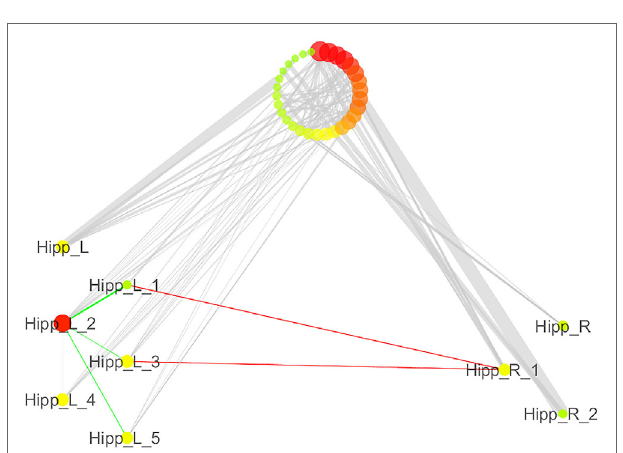
FigUre 7 | Detailed illustration of the role of the hippocampi in the coatrophy network of Alzheimer’s disease. Green edges are intrahemispheric, while red edges are interhemispheric.